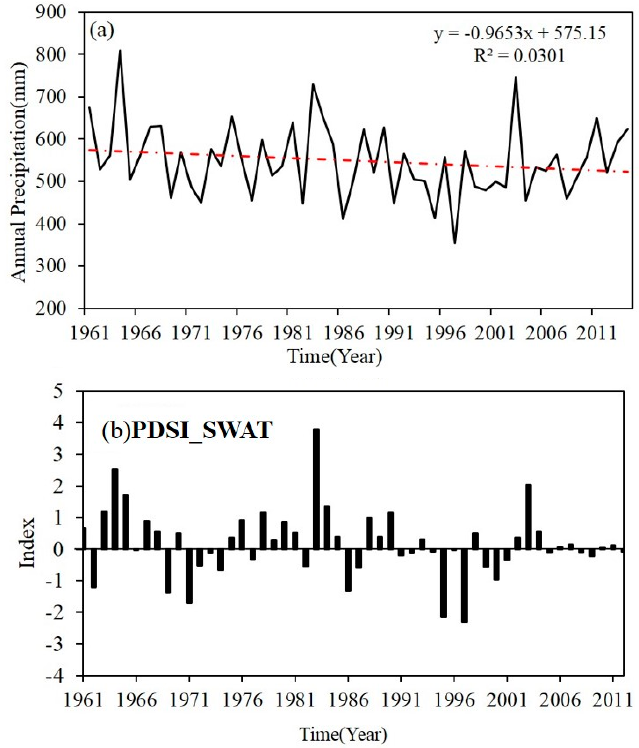
Figure 8. Interannual variation and trend of regional annual ( a ) precipitation and ( b ) PDSI_SWAT.